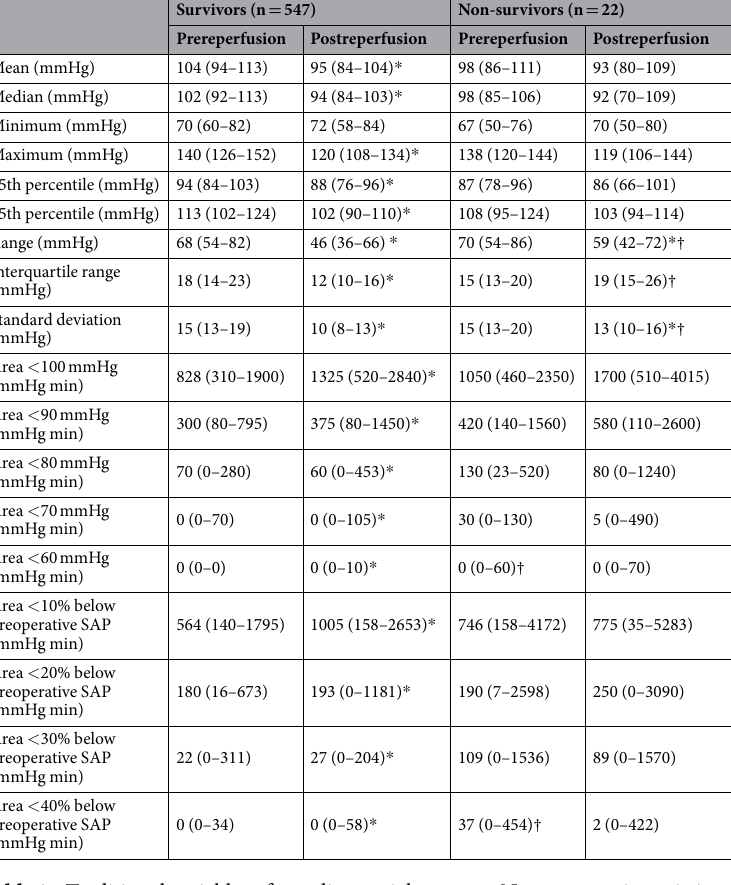
Table 2. Traditional variables of systolic arterial pressure. Nonparametric statistics are uniformly used because most values fail to pass normality test. Differences between periods and between groups are compared with Wilcoxon test and Mann–Whitney test, respectively. * P < 0.05 vs prereperfusion values, † P < 0.05 vs survivors. Abbreviation: SAP = systolic arterial pressure.